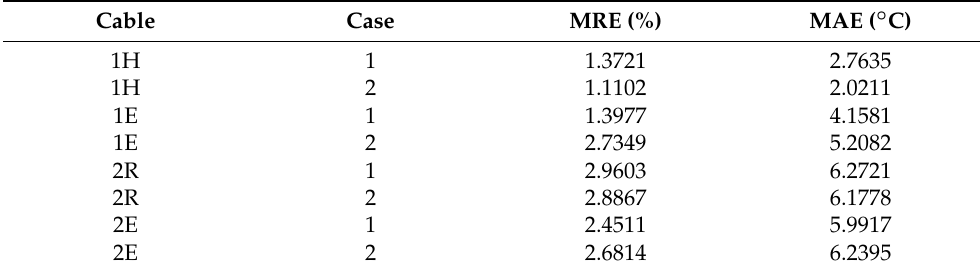
Table 4. Errors obtained from the application of the ETN-based model to the 4 cables.